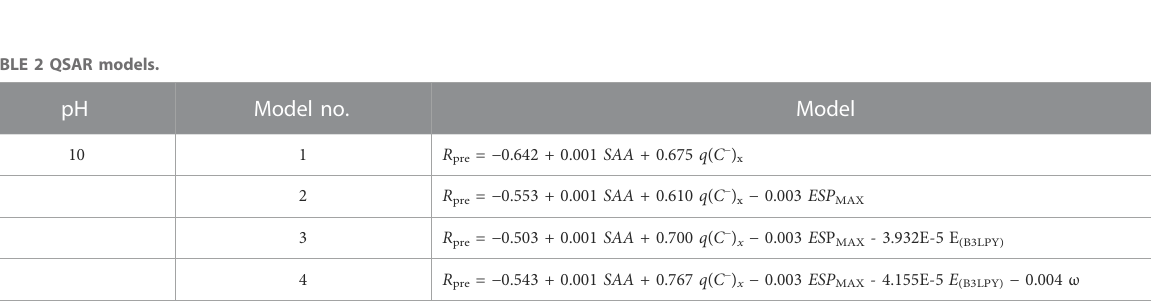
TABLE 2 QSAR models. pH Model no.